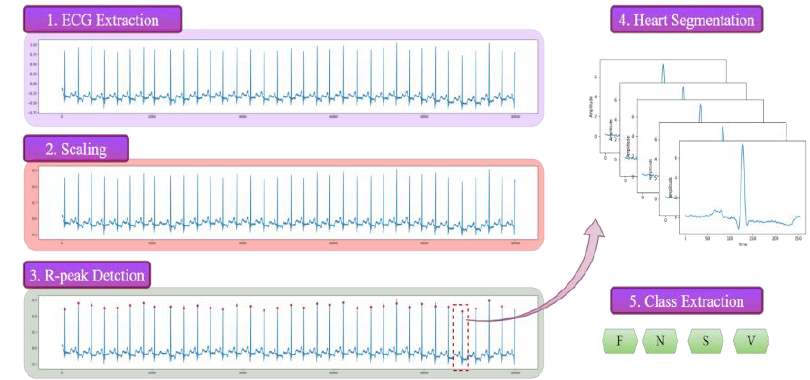
Figure 3. Heartbeat extraction pipeline.